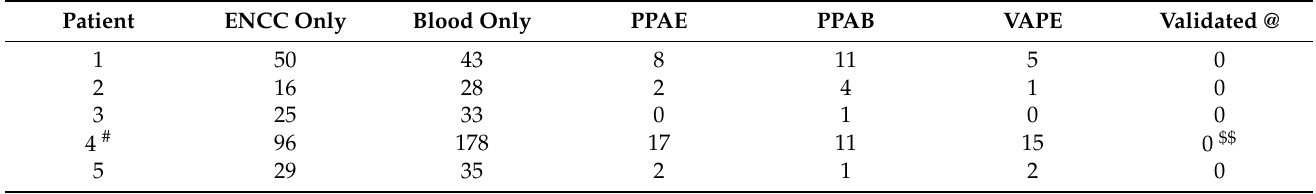
Table 1. Number of variants identified in each patient, passing subsequent quality and prioritization